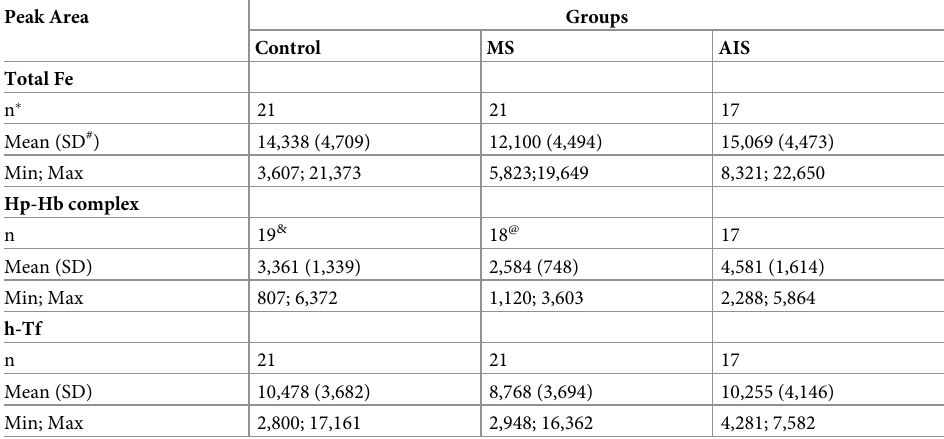
Fig 1. Fe-specific chromatograms obtained after the analysis of plasma from MS participants, AIS participants and healthy controls. Column: Superdex 200 Increase 10/300 GL (30 x 1.0 cm I.D., 8 μ m particle size), Temperature: 22˚C, Mobile phase: 150 mM PBS buffer (pH 7.4), Flow rate: 0.75 mL/min, Injection volume: 500 μ L. ICP-AES detection at 259.940 nm (Fe). Retention times of molecular weight markers are depicted on top. 750 μ L of plasma was diluted with 250 μ L of PBS buffer and 500 μ L of the obtained solution were injected on the SEC column.